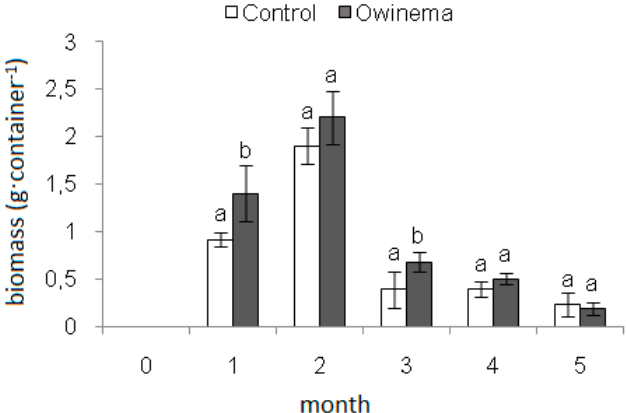
Figure 5. Mean biomass of E. fetida cocoons (g ∙ container − 1 ± SD) in experimental ecological boxes depending on the presence of Owinema bio-preparation (50 mln larvae m − 2 ) during a 5 month experiment (a, b indicate significant differences between two means).